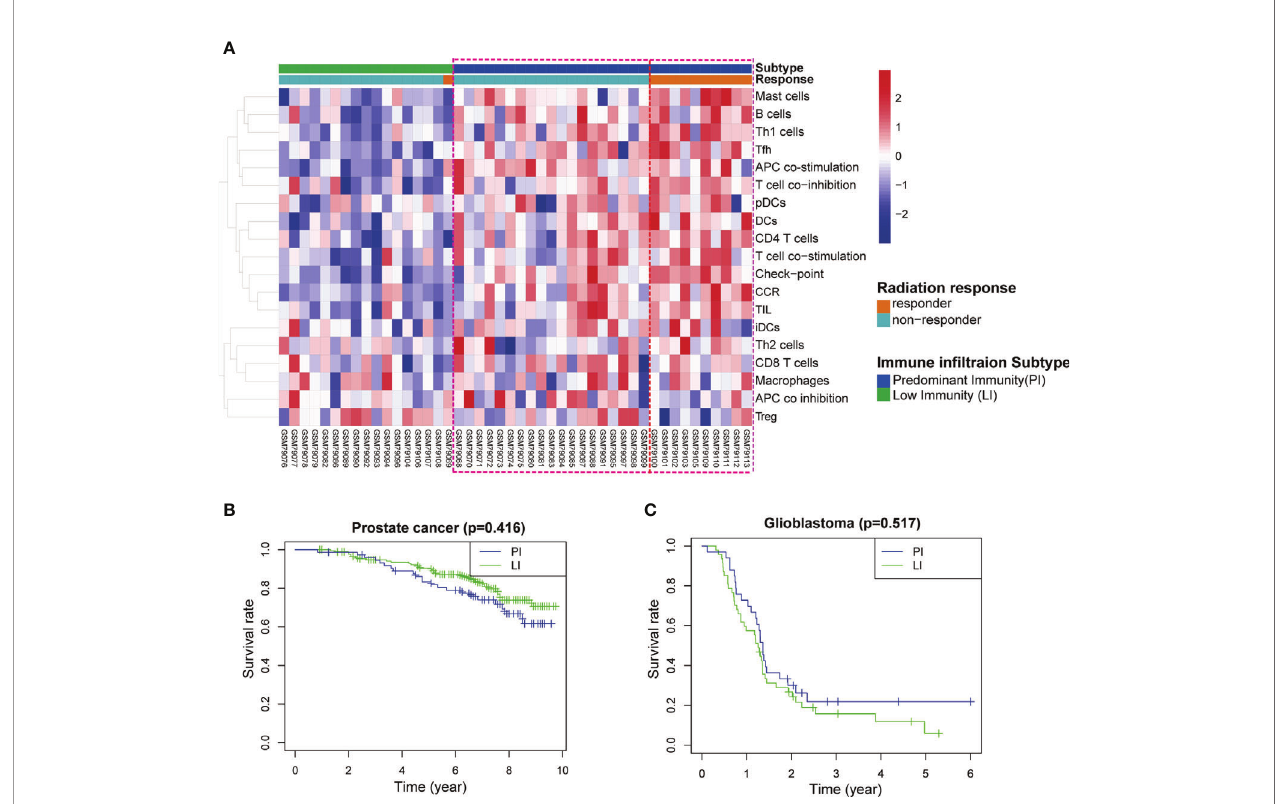
FIGURE 6 | Association between immune pro fi les of the tumor microenvironment and radiological response in three types of cancer patients. (A) Unsupervised clustering of 46 rectal cancer patients who received radiotherapy. The tumor microenvironment was divided into predominant immune groups (PI) and low immune (LI) groups according to single-sample gene-set enrichment analysis (ssGSEA) scores of 29 immune cell types. Patients were classi fi ed into two types of radiation response (responder and nonresponder) based on a semiquantitative classi fi cation system. (B, C) Kaplan – Meier survival curves for the PI and LI groups of cancer patients with (B) prostate cancer and (C)